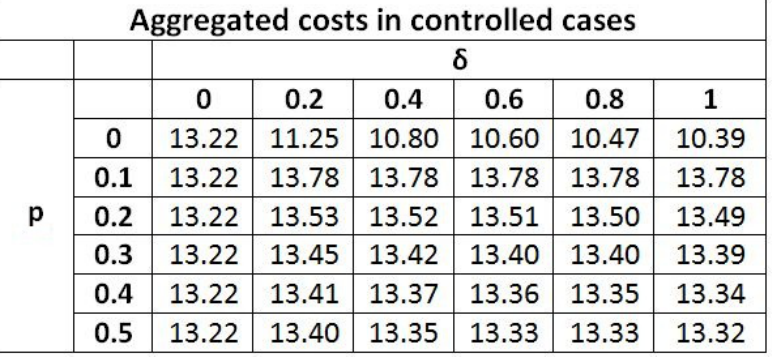
Figure 26. Experiment 5. Table of the dependence of aggregated costs on various values of the parameters δ 1 and p 1 in the controlled